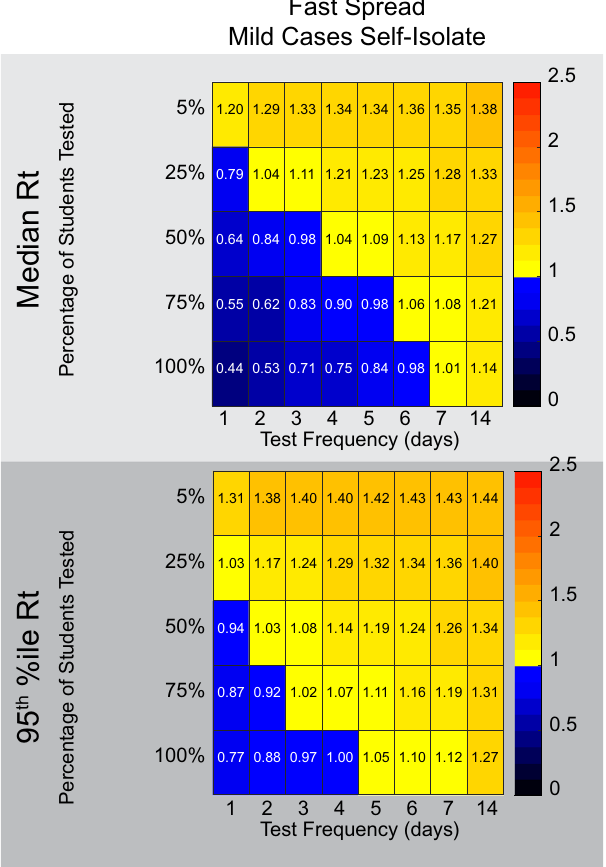
Figure 7. Assumptions about the behavior of people with mild symptoms influence the amount of testing required. Scenario 4 from Fig. 6 was repeated with the addition that people experiencing mild symptoms self- isolate on the day of symptom onset. Under these conditions, testing everyone every 4 days is sufficient to bring 95% of situations to an Rt of 1.00 or